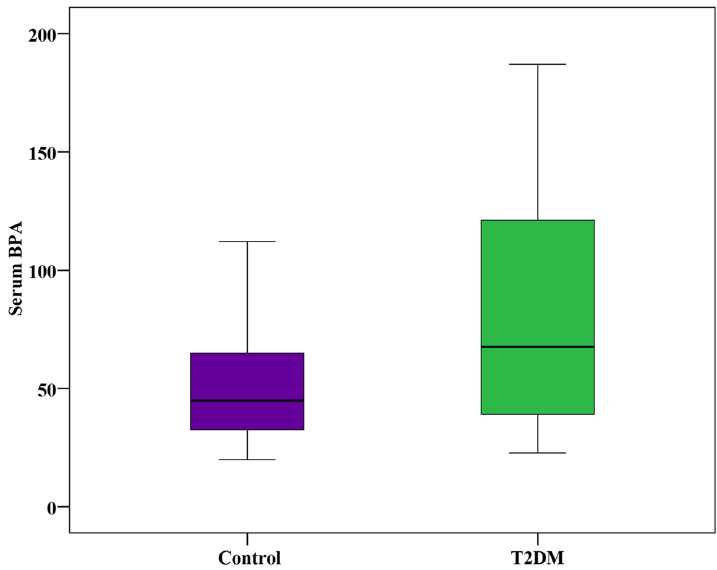
Fig. 1 Box plot showing the comparison between the two studied groups according to serum BPA (μg/ml) ( p